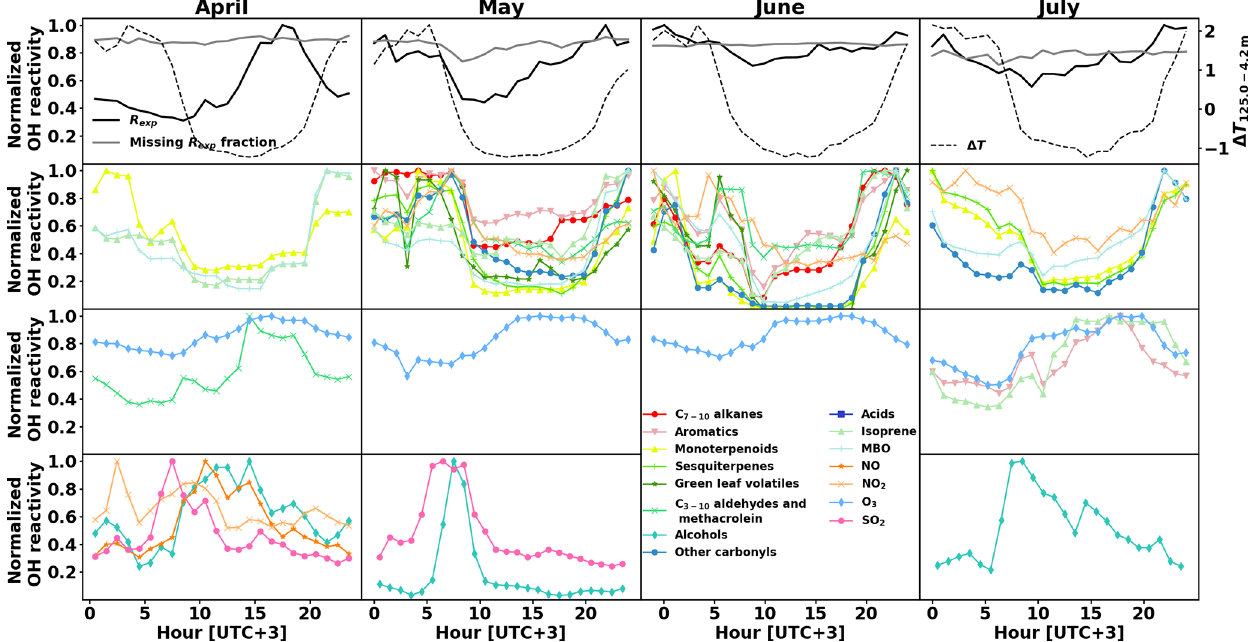
Figure 7. Normalized monthly averaged diurnal variations in experimental OH reactivity R exp and the missing fraction as well as temperature gradient between 4.2 and 125.0m above ground as a proxy for mixing layer height (top row), and calculated OH reactivity separated by group of compounds (second to fourth